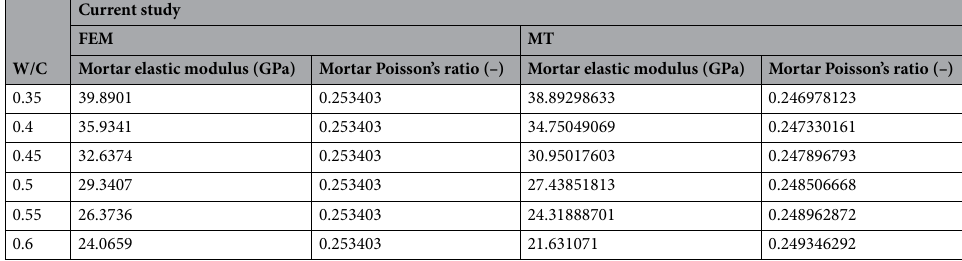
Table 4. Comparing MT and FE results for the effect of w/c ratio on the elastic properties at mesoscale.